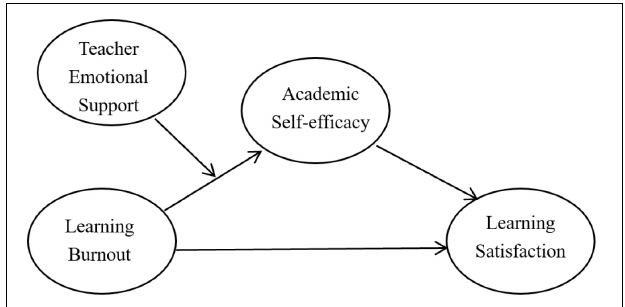
FIGURE 1 | The proposed moderated mediation